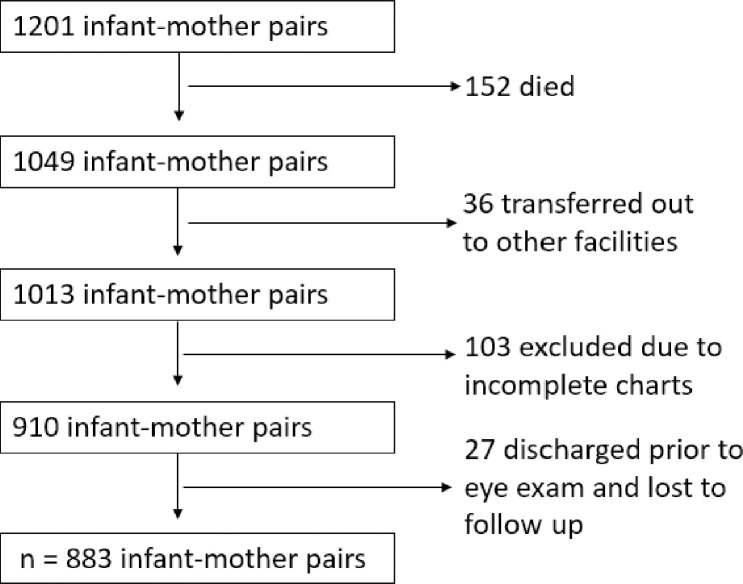
Flow chart of exclusion criteria.